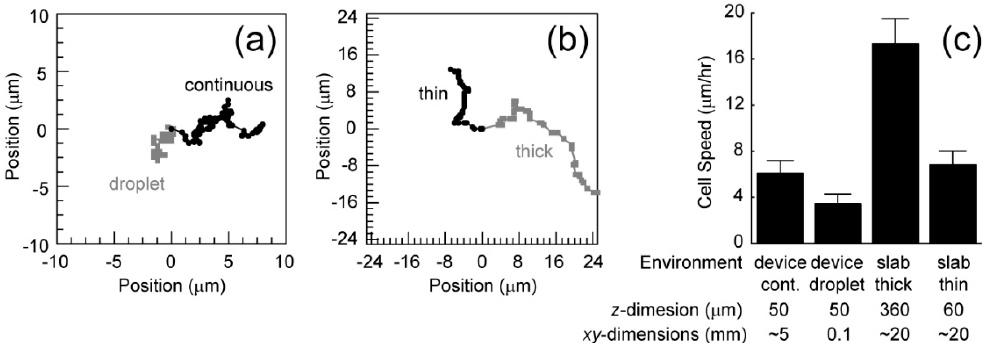
Figure 5. Representative trajectories of cells embedded in collagen (2 mg/mL) in the chip ( a ) and embedded in a collagen (2 mg/mL) slab between two coverslips (thick: grey, thin: black); ( b ) The chip is either filled with a continuous polymerized collagen network (grey) or droplets of collagen within the chambers (black); ( c ) Average cell speed under the different conditions as well as the length scales associated with each condition. Error bars are 95% confidence intervals.